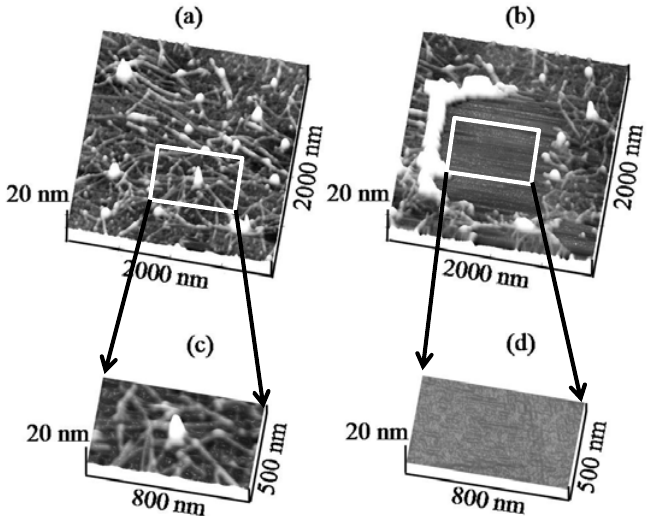
Figure 1. CM-AFM topography images before (a) and (c) and after (b) and (d) the forced scan in a 1 µm × 1 µm scan